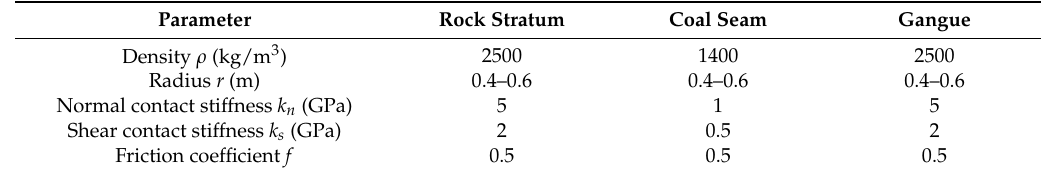
Table 2. Parameter setup of the gangue backfilling model in the goaf.